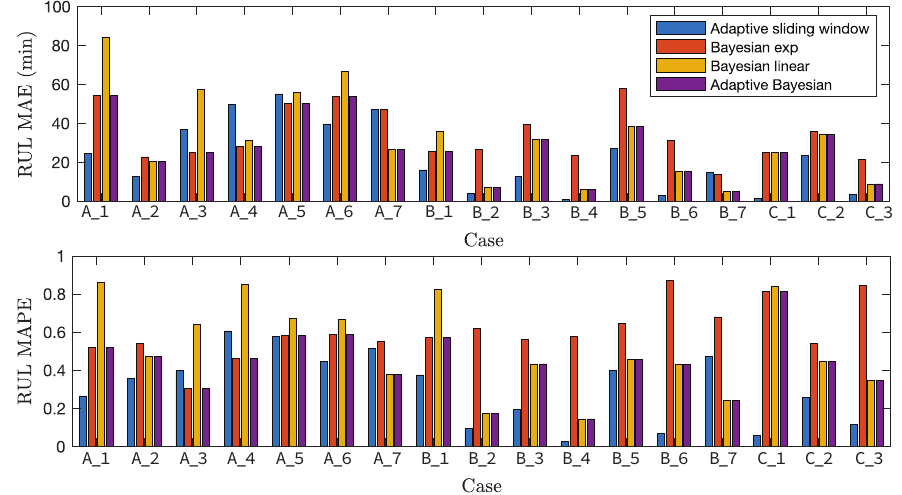
Figure 8. RUL MAE and MAPE obtained by adaptive sliding window method, Bayesian methods using the exponential and the linear degradation models, and adaptive Bayesian method for all